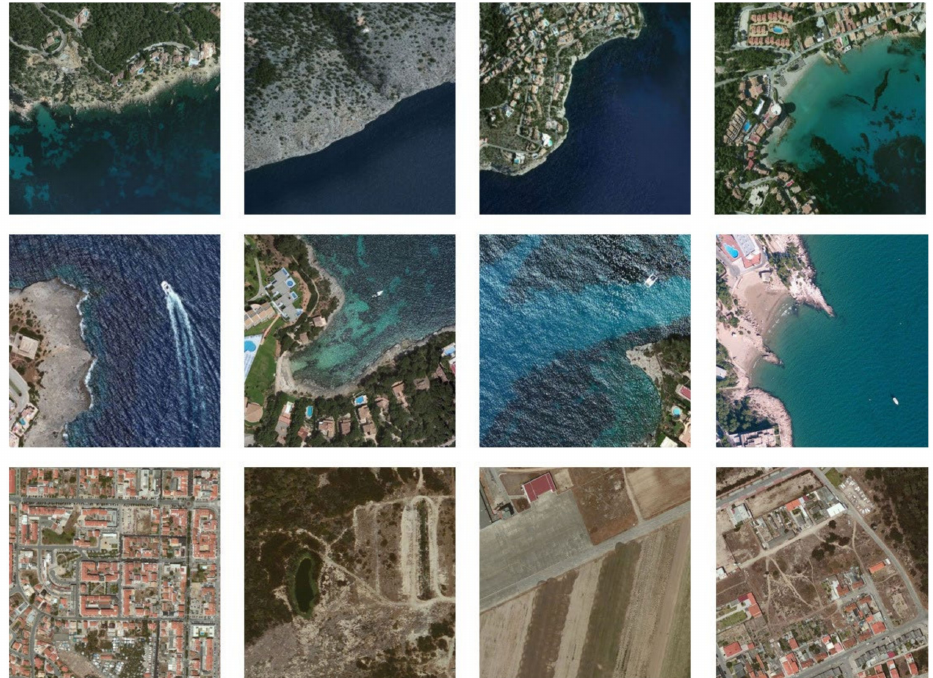
Figure 3. The samples in the MASATI remote sensing image dataset have high requirements for the performance of the classification model. Most remote sensing images of marine scenes contain a large number of wave ripples as interference. Especially for several types of data related to ships, the ship itself will be mixed with white ripples, which will increase the difficulty of classification and require a high local feature extraction ability of the model. The network also needs to be able to distinguish single ships, multiple ships, and land ships, which further requires the network to have the ability to capture global